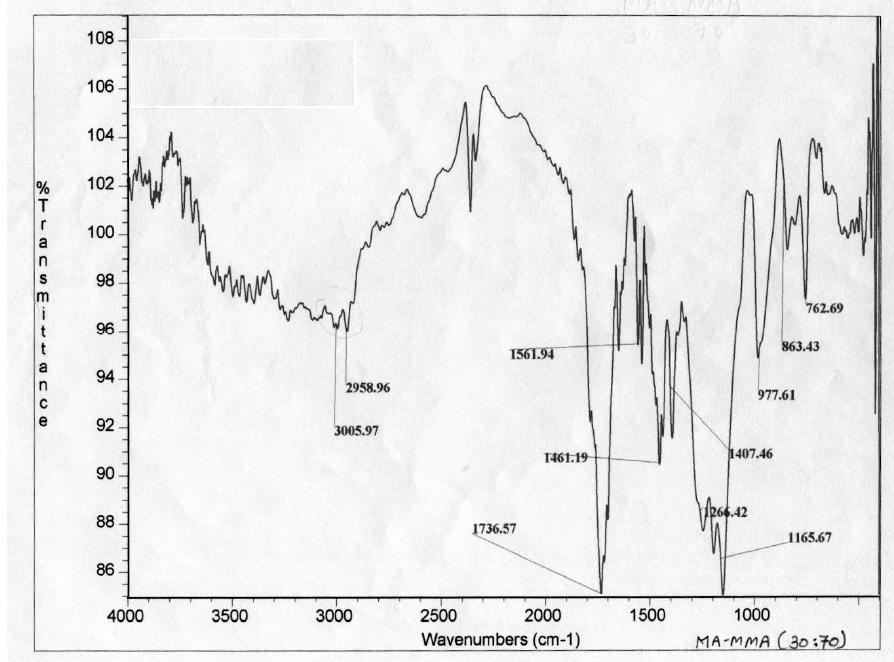
Figure 3. IR spectrum of AAR (MA-MMA (30: 70 wt/wt)